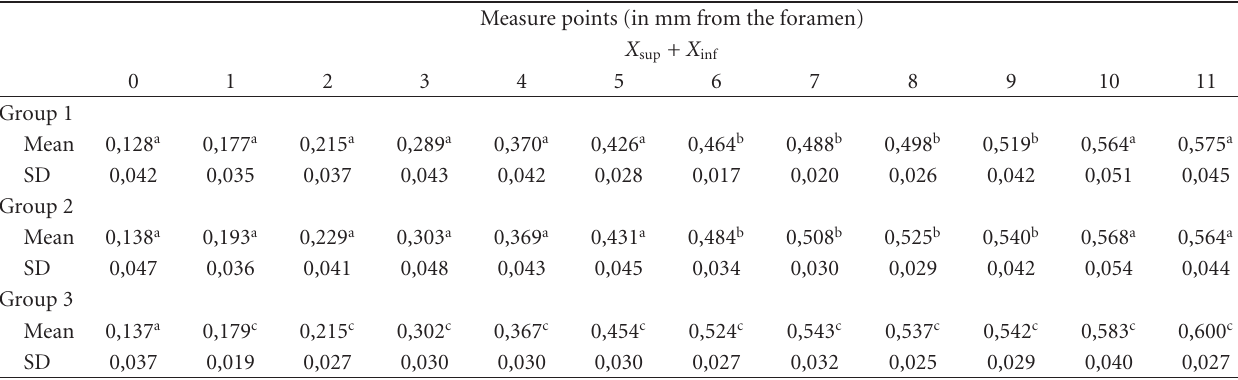
Table 1: Total quantity means of removed resin (mm) and Standard Deviations (SD) at the di ff erent measure points after root canal pre- paration.